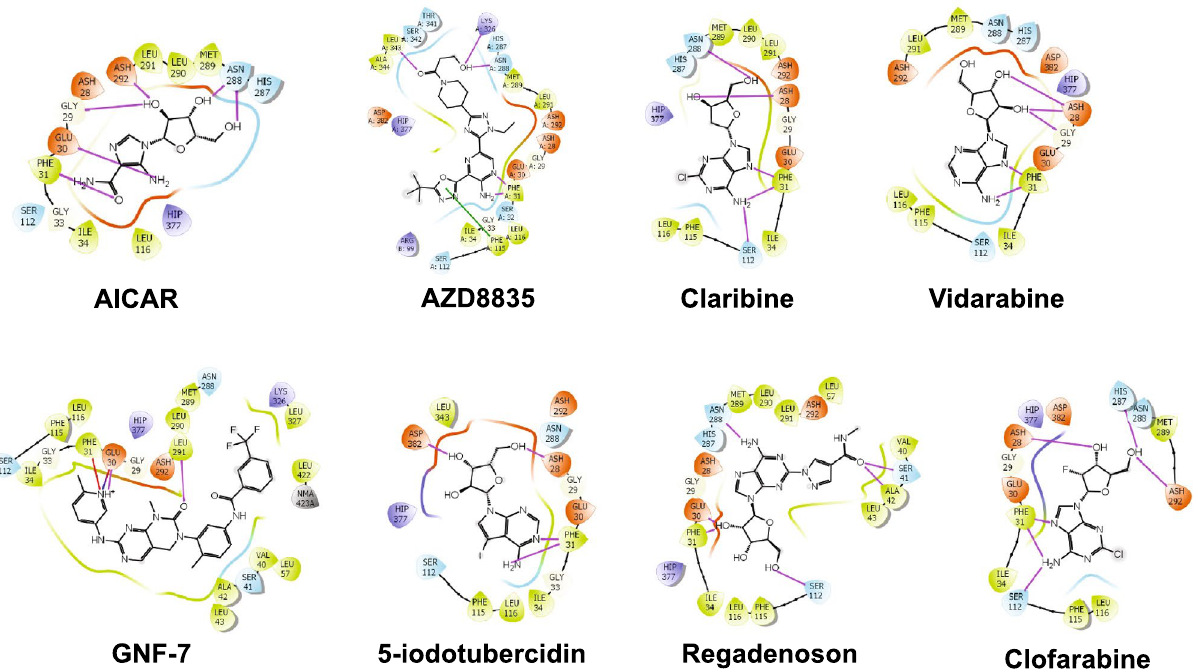
Figure 4. Docking of small molecule adenosine analogs into the PARN catalytic site. Ligand interaction map of the predicted binding mode of AICAR, AZD8835, Claribine, Vidarabine, GNF-7, 5-Iodotubercidin, Regadenson, and Clofarabine, where red residues are charged negative, purple residues are charged positive, green residues are hydrophobic, and blue residues are polar, magenta arrows indicate H-bonds, violet lines indicate salt bridges, and gray spheres represent areas of solvent exposure. HIP represents the ND1 and NE2 protonation state of His and NMA represents N -methyl amide of a capped termini. At least one H-bond interaction was observed between the docked small molecule and amino acid residues